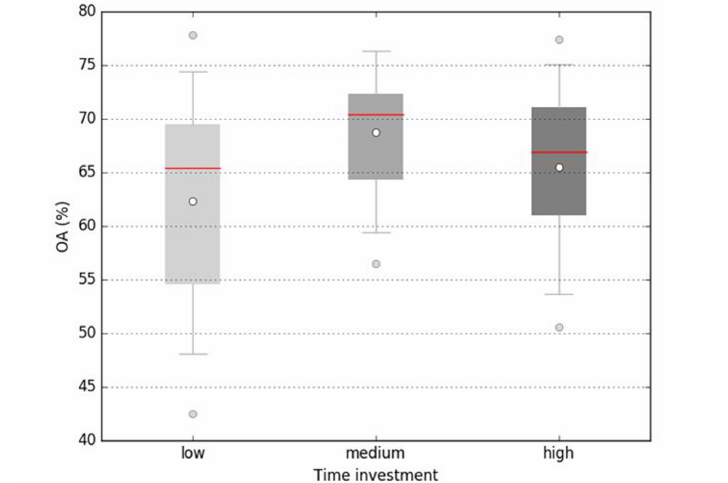
Figure 9. Overall accuracy based on overall time investment. Median OA: red stripe; average OA: white dot; boxplot ends: first and third quantile; whiskers: + / − the 1.5-fold interquartile range on OA values and outliers: grey